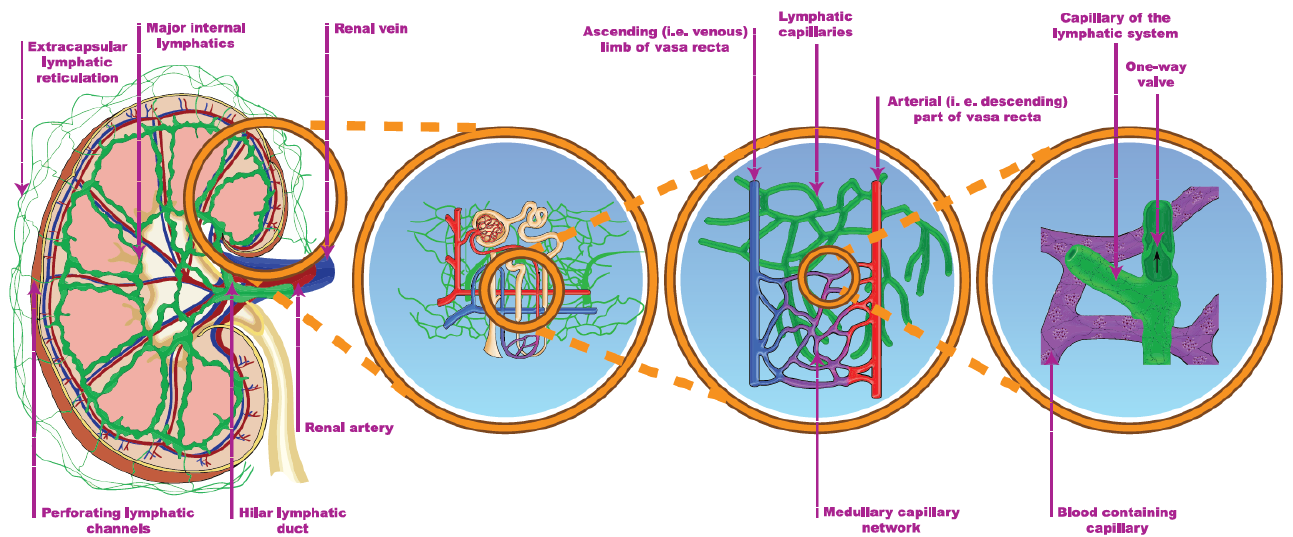
Figure 4. The renal lymphatic system (hilar and capsular). Red vessels: arteries; blue vessels: veins; purple vessels: connection vessels between arteries and veins; yellow tubes: urine conducting system; green vessels: lymphatic network.